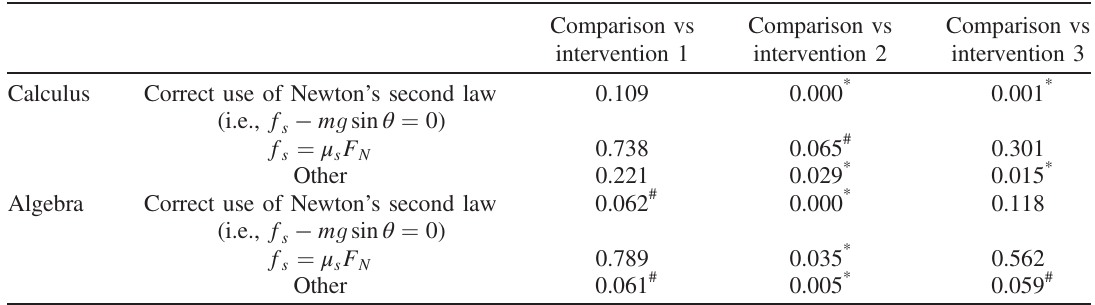
TABLE VII. P-values (using the Chi-square tests) for the comparison of the number of students who used various problem-solving approaches in different groups. The differences that are significant are indicated by the asterisk ( * ). The pound symbol ( # ) indicates a marginally significant difference with a p-value between 0.05 to 0.10.